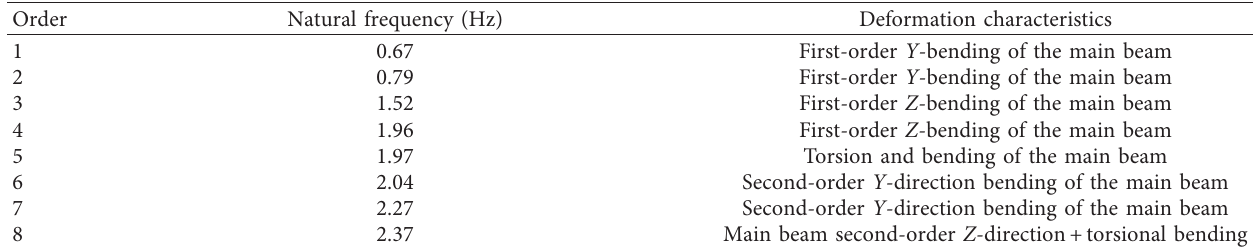
Table 1: The natural frequency and deformation characteristics of Model 1.